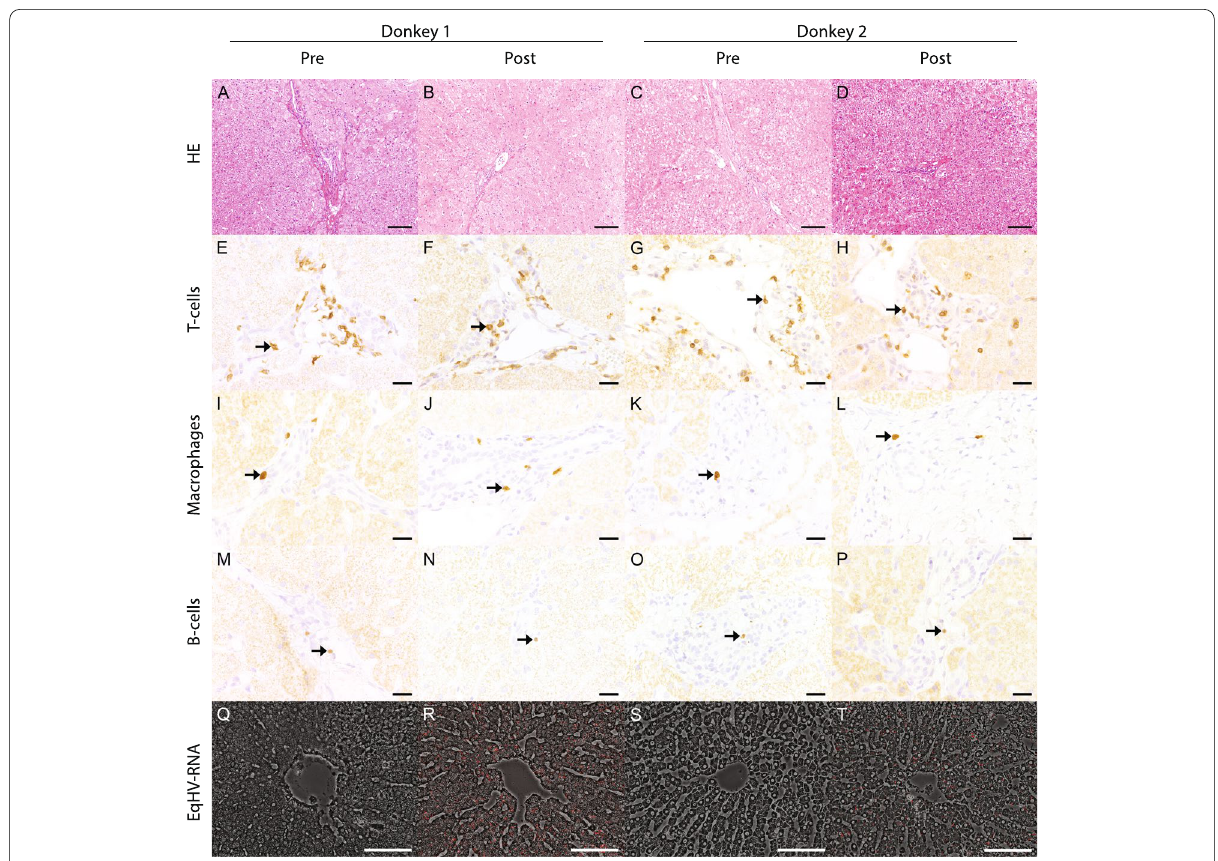
Fig. 2 Morphological findings in liver biopsies from donkeys pre- and post- infection with EqHV. A‑D Histologically, a mild periportally-accentuated, lympho-histiocytic inflammation was detected within liver biopsies with a similar appearance in samples taken pre- ( A, C ) and post- ( B, D ) infection. Hematoxylin and eosin, scale bar 100 μm. E‑P Inflammatory cell infiltrates consisted mainly of T-lymphocytes ( E‑H , asterisk), fewer macrophages = ( I‑L , asterisk) and single B-lymphocytes ( M‑P , asterisk) pre- and post-infection. Immunohistochemistry, scale bar in situ-hybridization lacked a positive reaction pre-infection ( Q, S ). Post-infection, EqHV specific RNA sequences were detected within the cytoplasm ( R, T ). Scale bar 100 =